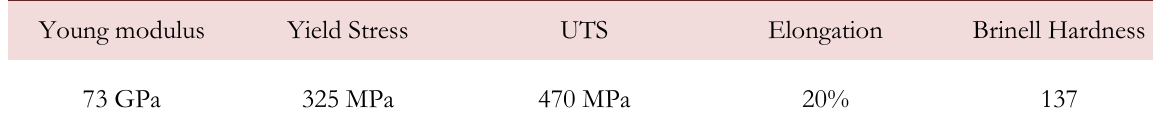
Table 1: Mechanical properties of 2024-T351 aluminium